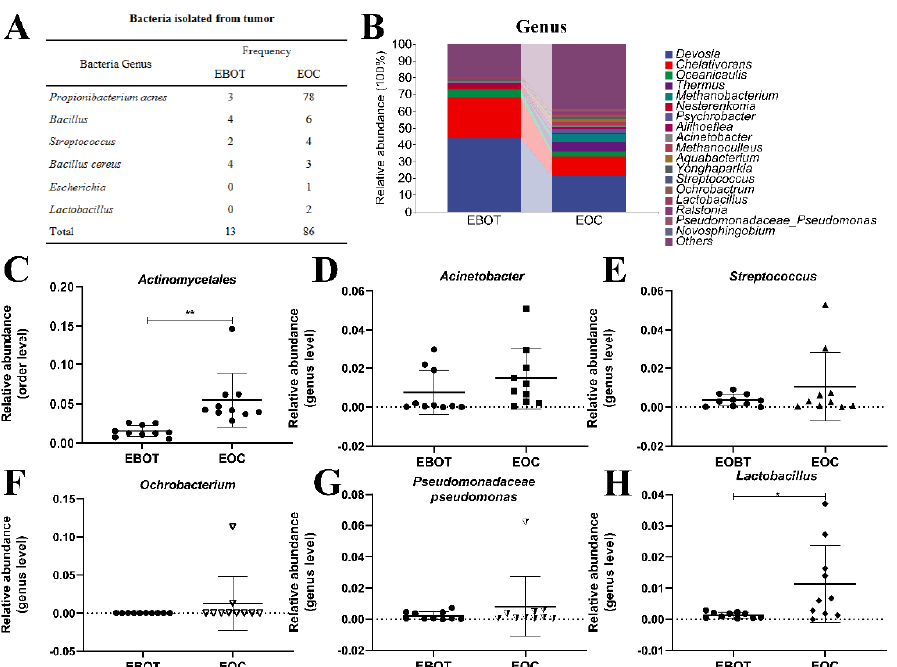
Figure 2. Isolation of intratumour microbiota and identification of key strains. ( A ) Table showing the culture isolated bacteria genera in EBOT and EOC. ( B ) Microbial composition in epithelial ovarian tumours at the order and genus level. The relative abundance of ( C ) Actinomycetales , ( D ) Acinetobacter , ( E ) Streptococcus , ( F ) Ochrobacterium , ( G ) Pseudomonadaceae pseudomonas , and ( H ) Lactobacillus were analysed. Data are presented as means ± SD; * p < 0.05, ** p < 0.01.